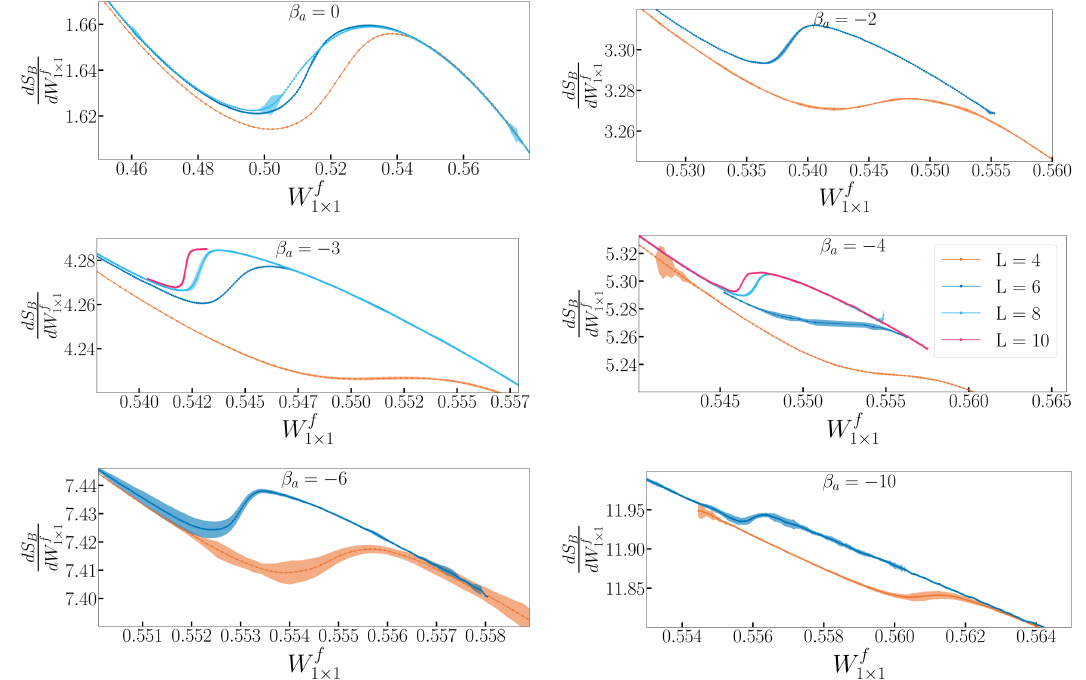
, as a function of W f , for different 1 × 1 1 × 1